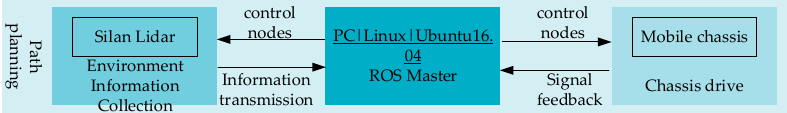
Figure 2. Mobile chassis control system diagram.